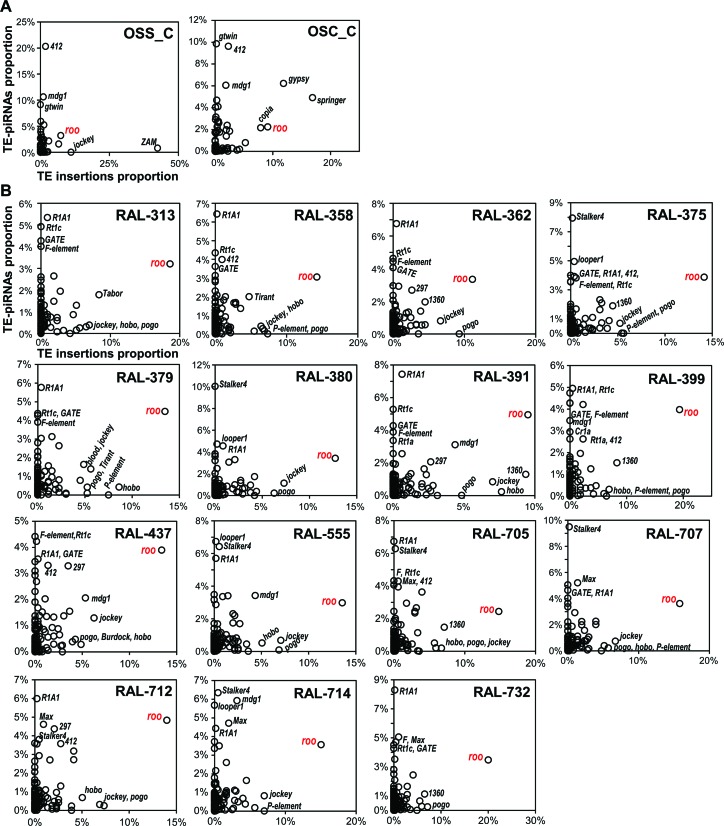
Comparisons of TE-directed piRNAs versus TE Insertions for OSS/OSC cells and DGRP fly strains. Scatterplots compare the relative proportions of TE-directed piRNAs and TE insertions for each sample in (A) OSS and OSC cells and (B) DGRP fly strains with sequenced piRNAs and genomes sequenced by Illumina. The roo transposon is highlighted for its exceptionally high proportion of strain-specific insertions despite the high proportions of roo-directed piRNAs.